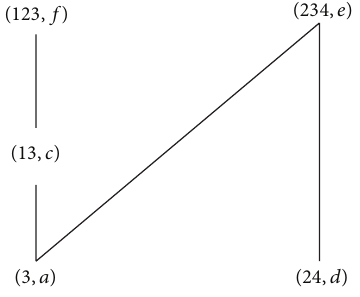
Figure 6: (𝐻 𝐶 𝑚 , ≤) of (𝐺, 𝑀,𝐼 𝑐 ) in Table 2. Table 4: The arrow relation ↗ of (𝐺, 𝑀,𝐼 𝑐 )